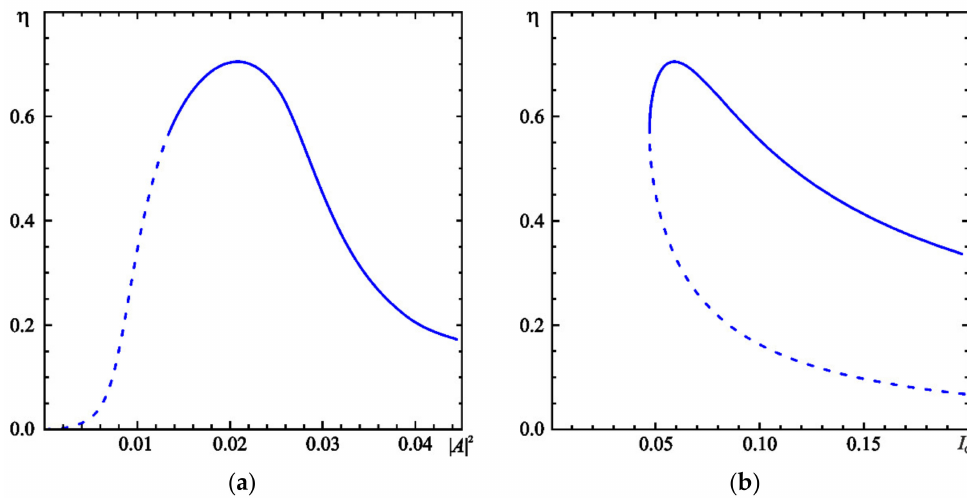
Figure 2. Orbital electronic efficiency versus | A | 2 ( a ) and versus I 0 ( b ) calculated at µ = 15.0 and ∆ = 0.534. Stable and unstable states are shown with solid and dotted lines, H